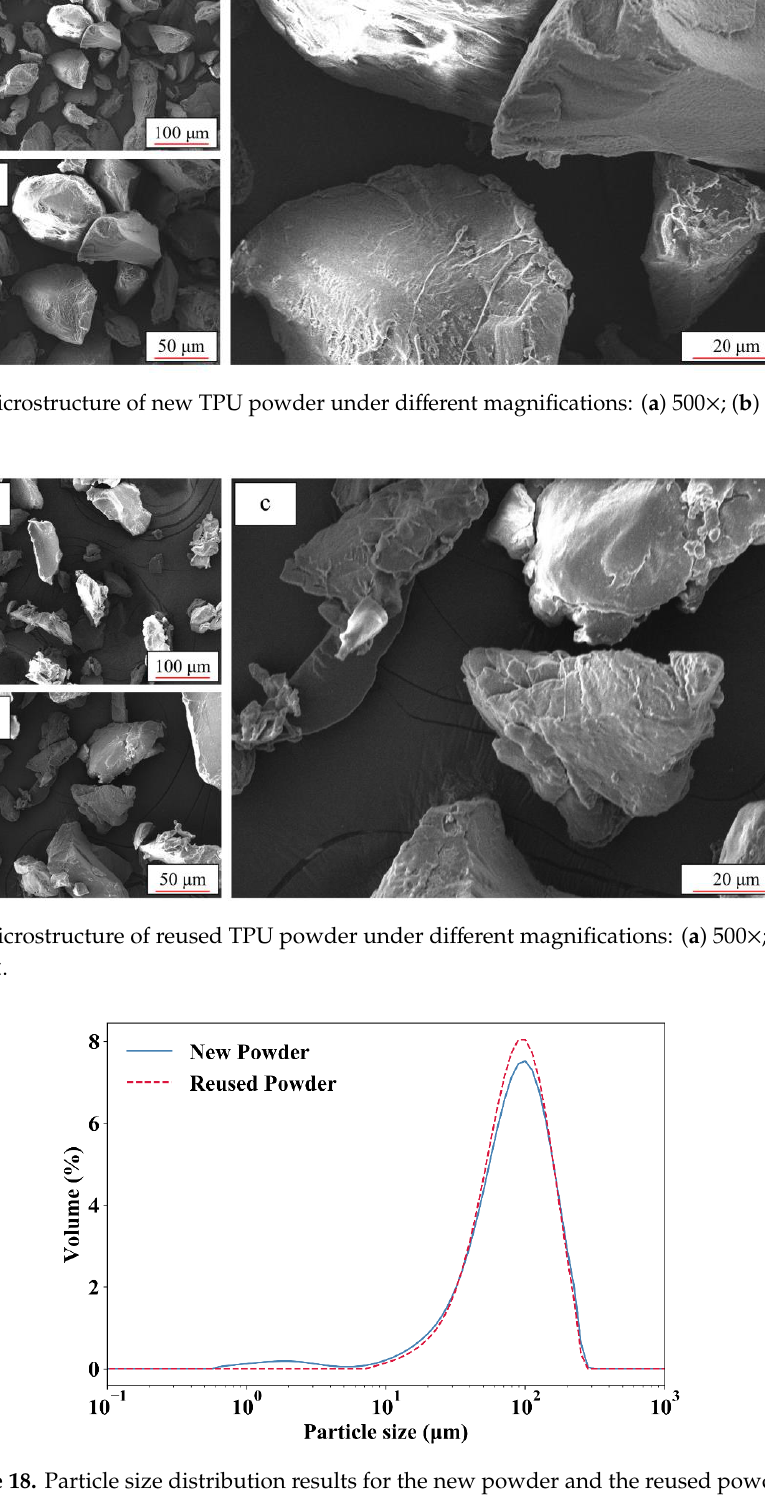
Figure 18. Particle size distribution results for the new powder and the reused powder.